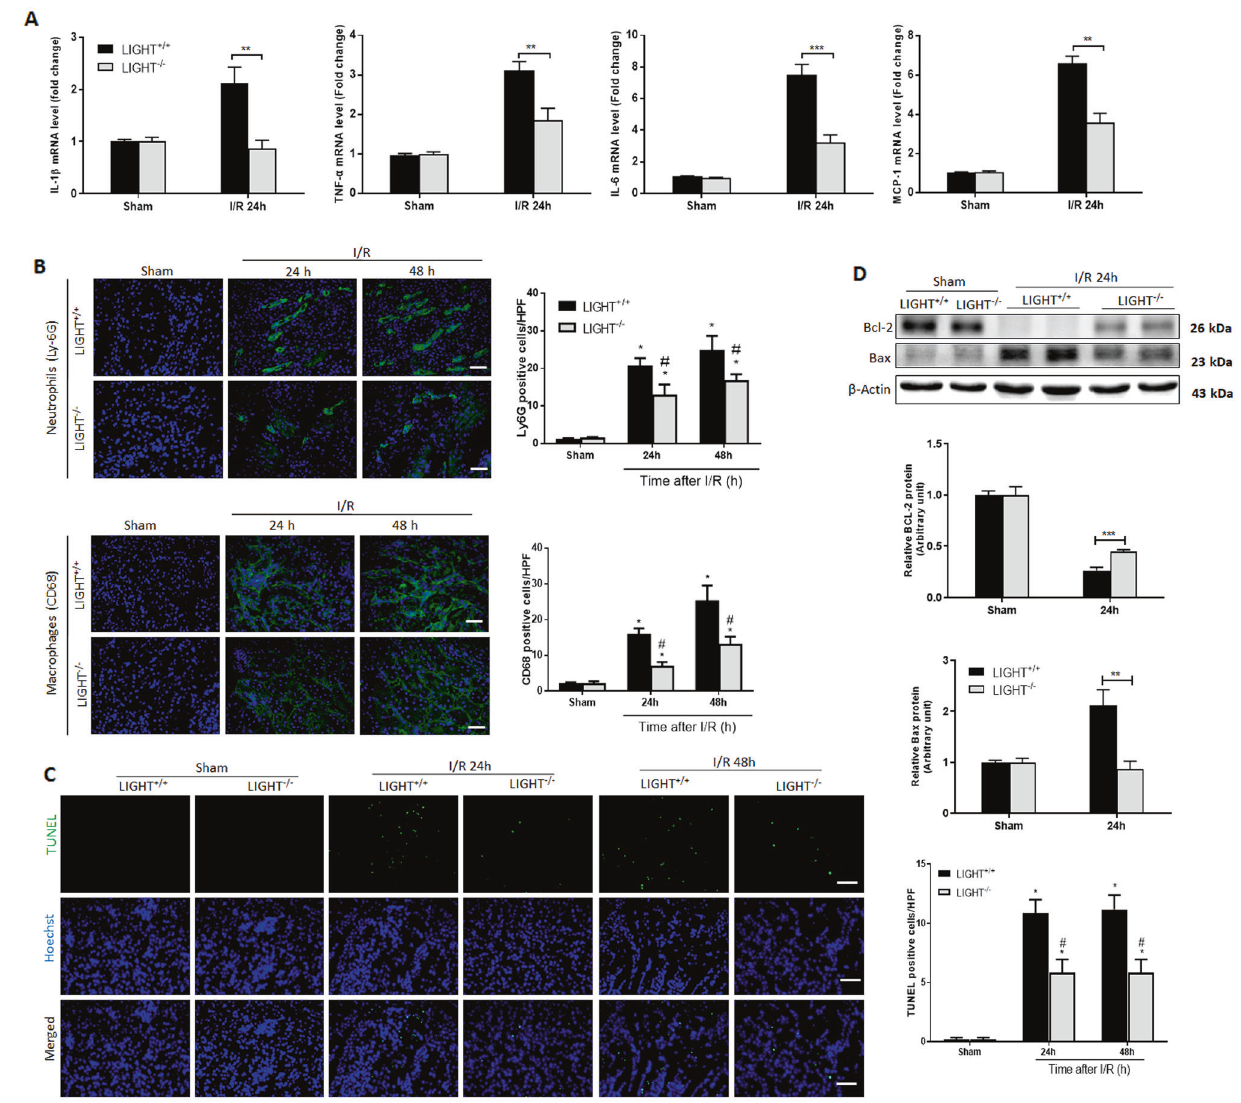
Fig. 4 De fi ciency of LIGHT reduces in fl ammation and tubular apoptosis after I/R injury. Wild-type (LIGHT + / + ) and LIGHT (LIGHT − / − ) mice received renal ischemia or sham surgery followed by reperfusion for indicated time points. A After 24 h reperfusion injury, kidney samples were assessed for indicated cytokine expression by qRT-PCR ( n = 5 – 6). B Representative micrographs and quanti fi cation of immuno fl uorescence staining for neutrophils (Ly-6G) and macrophages (F4/80). The nucleus was co-stained with Hoechst 33258 (blue). ( n = 5 – 6). Scale bar, 50 μ m. C Western blotting for Bcl2 and Bax expression from kidney lysates after 24 h reperfusion injury, and a densito- metric analysis is shown in the underlying panel. D IF staining and quanti fi cation for TUNEL-positive apoptosis tubular cells. The nucleus was co-stained with DAPI (blue). Scale bar, 50 μ m. Data are shown as mean ± SEM. ( n = 6 – 8 for each group). Differences between the two groups were assessed with Student ’ s t test. * p < 0.05 vs. sham group; # p < 0.05 vs. LIGHT + / + mice with